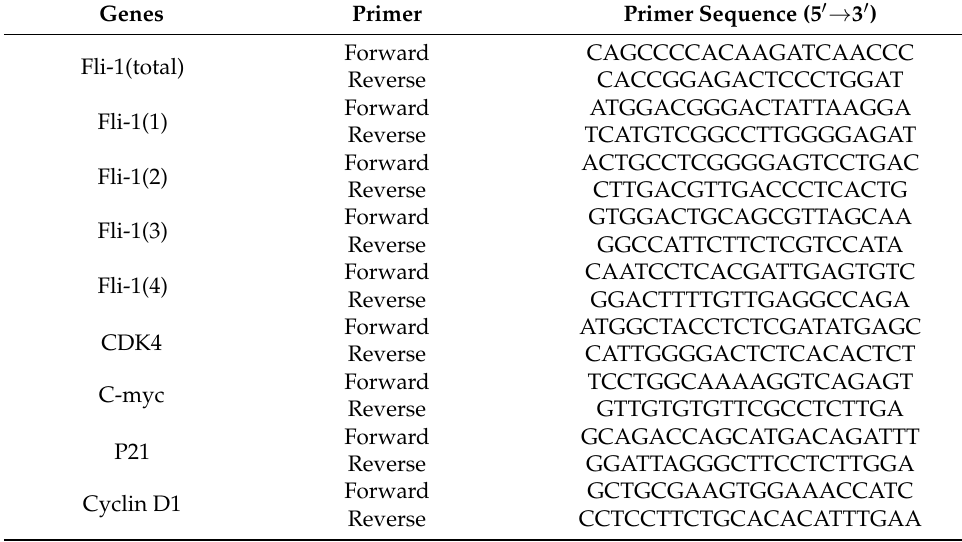
Table 3. The sequences of the primers used in this study. Genes Primer Primer Sequence (5 (cid:48) → 3 (cid:48)